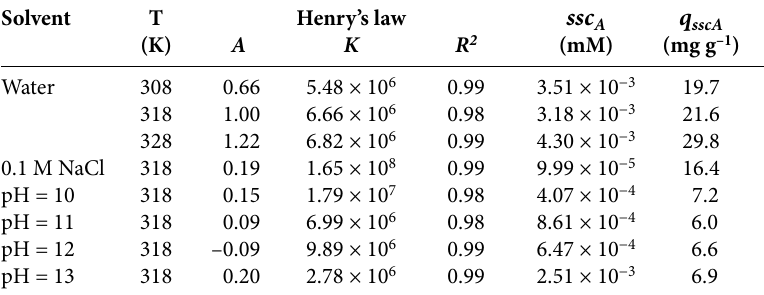
Table 1 . Parameters obtained from the Henry’s law an ssc A and q sscA values for adsorption of CR on Mg-Al-LDH nanocompound in water and 0.1 M NaCl solutions in region I (on MP site) at 308–328